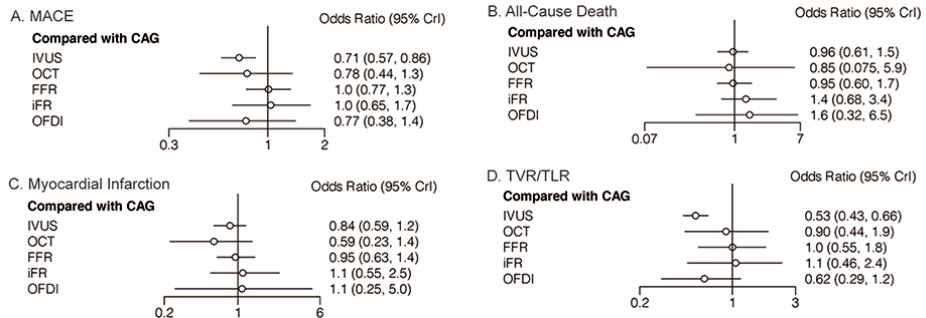
Figure 2. Comparisons of clinical outcomes among guidance modalities included in the network meta-analysis. CAG: coronary angiography; FFR: fractional flow reserve; iFR: instantaneous wave- free ratio; IVUS: intravascular ultrasound; MACE: major adverse cardiovascular events; OCT: optical coherence tomography; OFDI: optical frequency domain imaging; TVR/TLR: target vessel/lesion revascularization. ( A ) MACE; ( B ) All-Cause Death; ( C ) Myocardial Infarction; ( D ) TVR/TLR. Table 1. Main analysis for clinical